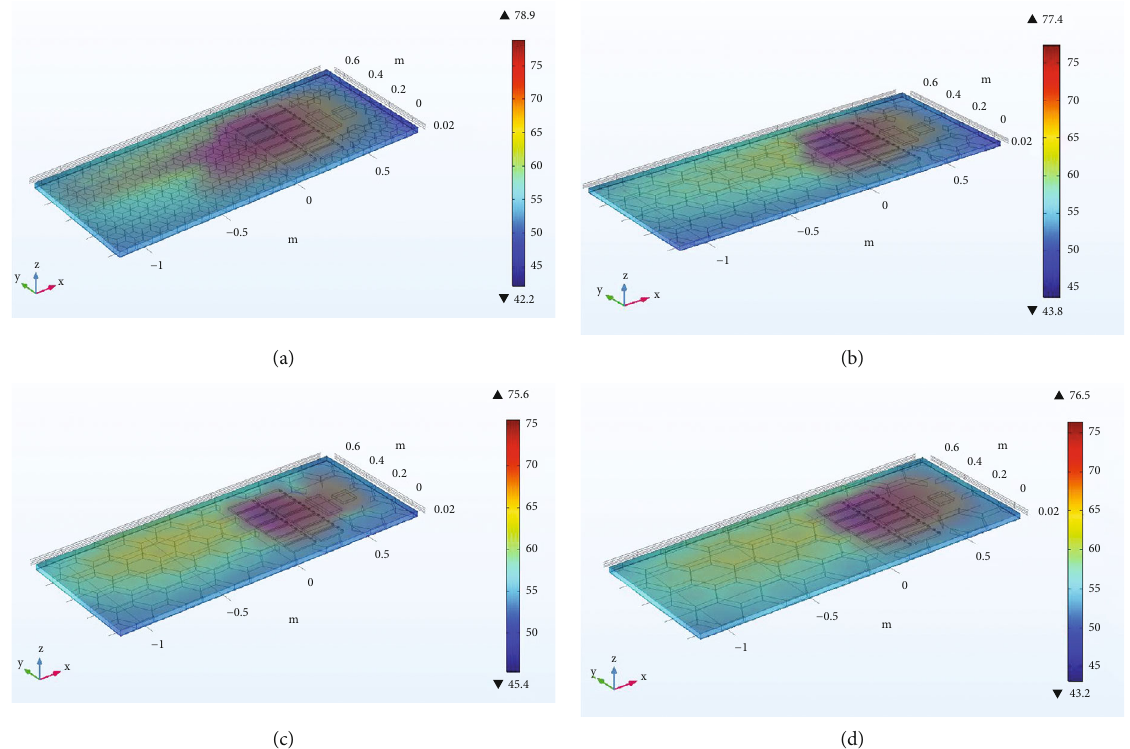
Figure 12: Temperature contours of H – PBIS with di ff erent side lengths of aluminum honeycomb: (a) 45 mm, (b) 75 mm, (c) 90 mm, and (d) 105 mm under air convection condition at 25000 s.